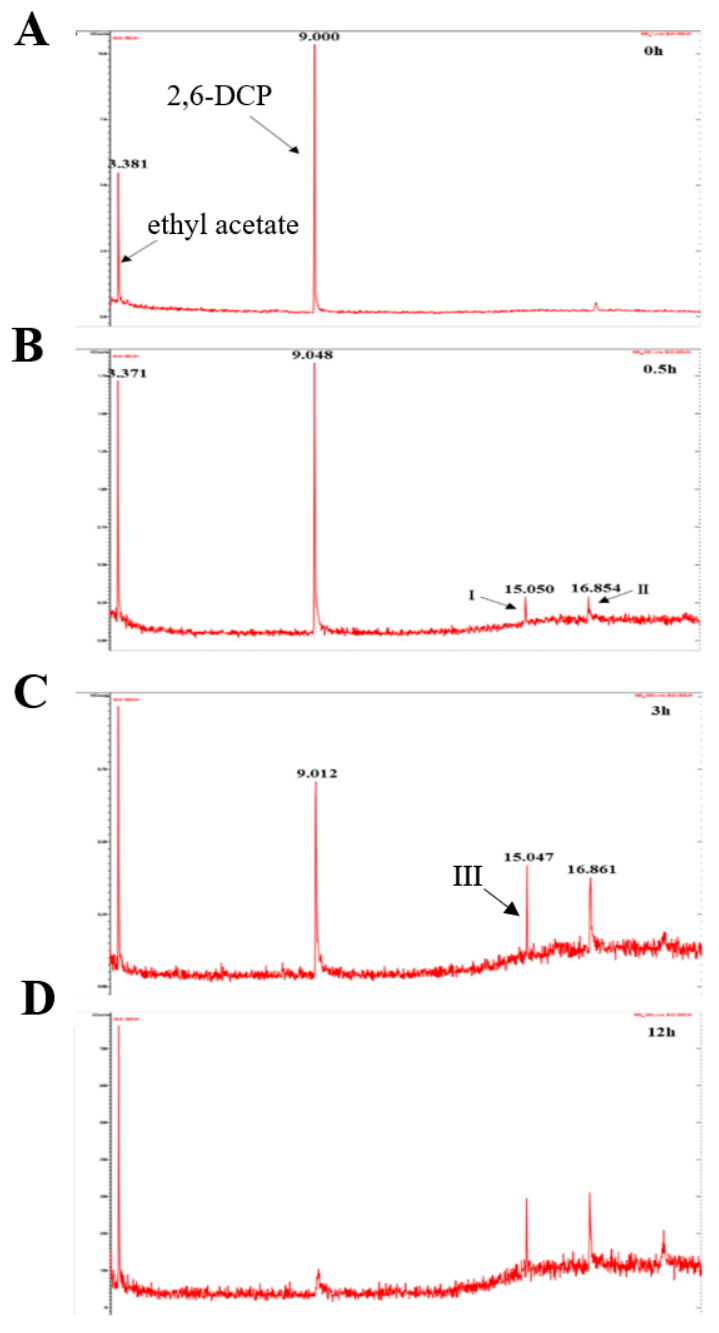
Figure 9. Gas chromatography (GC) peak spectra of degradation products of 2,6-DCP degraded by LAC-4 at different time points. ( A ) 0 h, ( B ) 0.5 h, ( C ) 3 h, ( D ) 12 h.